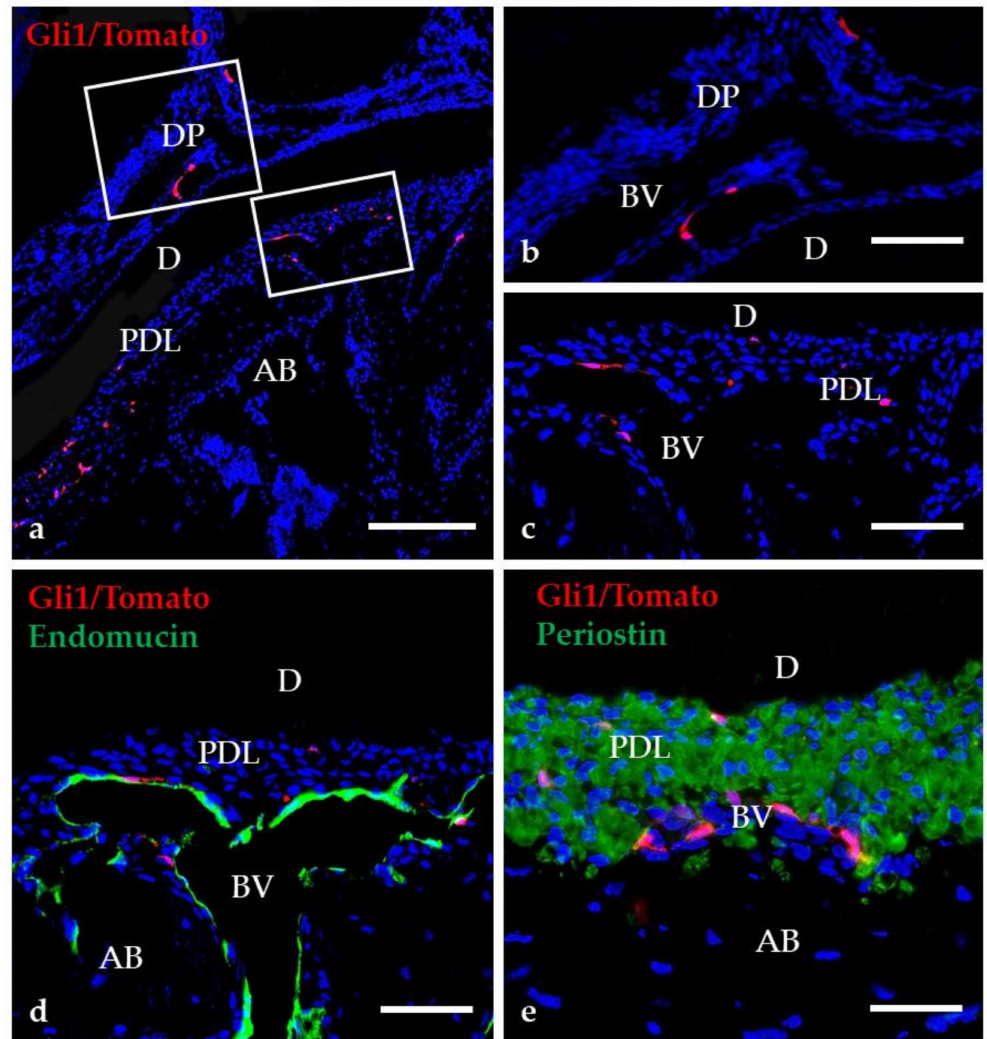
Figure 3. Distribution of Gli1-positive cells in mature teeth. Higher magnification of the boxed region in “a” are shown in “b”–“e.” ( a–c ) Gli1-positive cells are present in the dental pulp (DP) and the periodontal ligament (PDL). ( d–e ) The merged image of Endomucin and Periostin with Gli1 / Tomato fluorescence demonstrate that most Gli1 / Tomato-positive cells are distributed near blood vessels (BV). AB, alveolar bone; D, dentin. Scale bars = 100 µ m ( a ), 25 µ m ( b–e